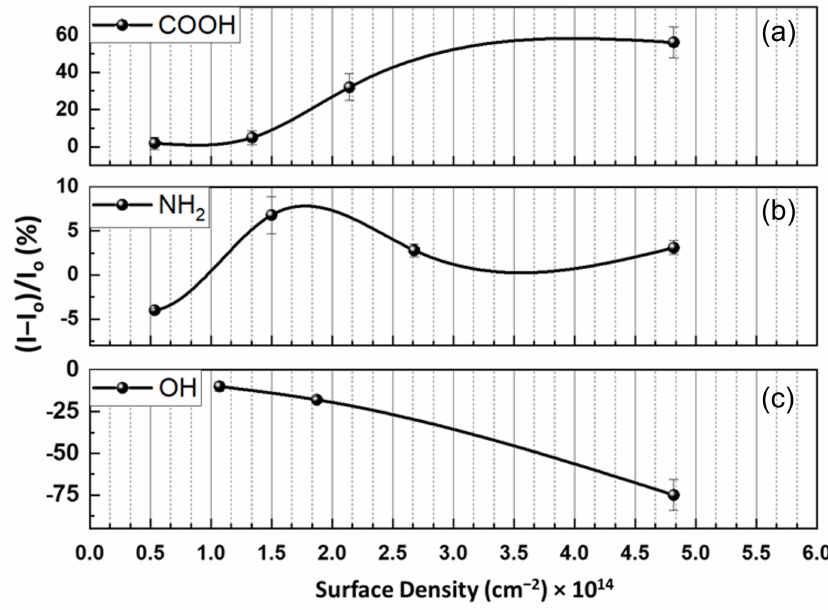
Figure 5. Variation of FLG pH sensitivity as a function of ( a ) carboxyl, ( b ) amine, and ( c ) hydroxyl defect densities. The error bars represent average ± standard deviation of the last two minutes of the chemiresistive response (3 samples each).